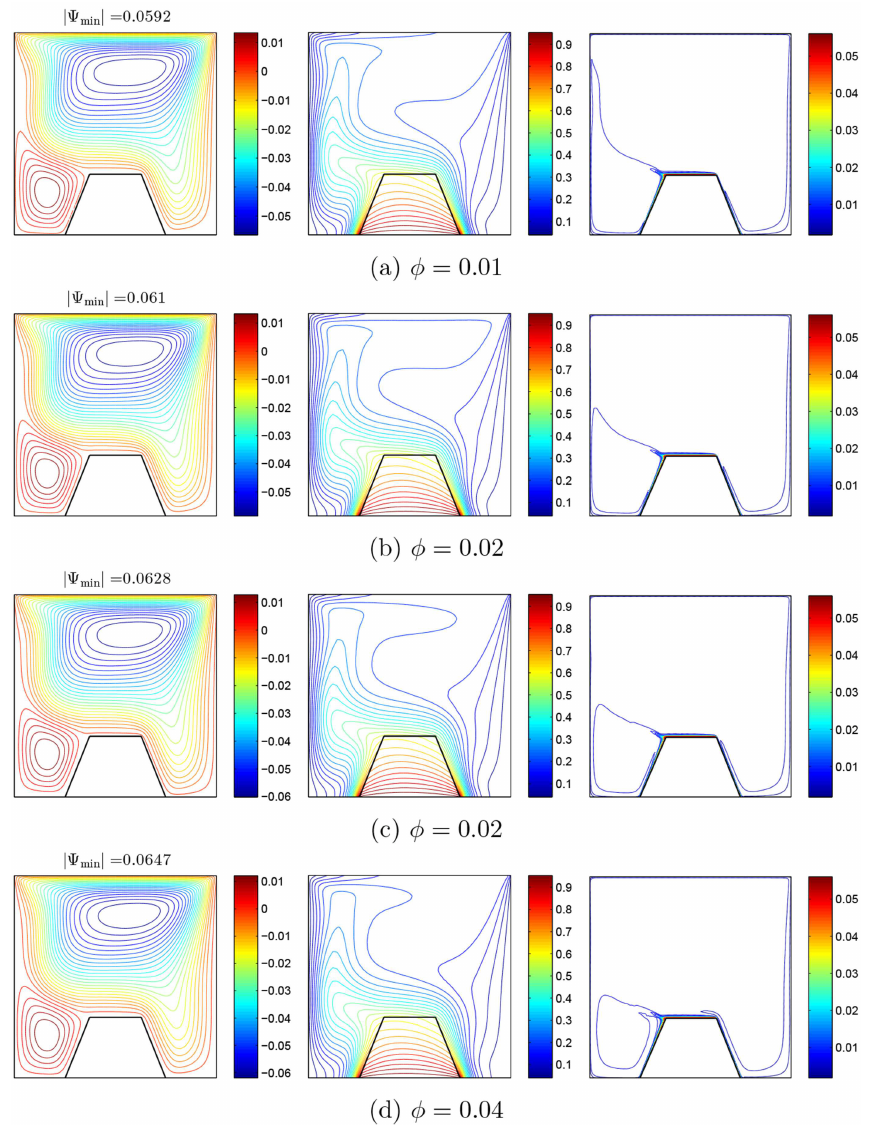
Figure 8. Effects of the solid volume fraction ( φ ) on the streamlines (left), isotherms (middle), and nanoparticle distribution (right) for Ri = 10, Ha = 15, and D =